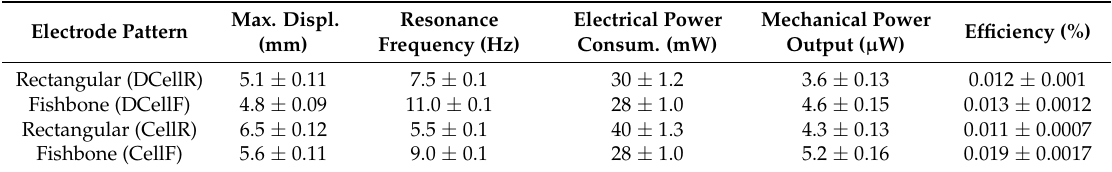
Table 4. Electrode pattern effect on the actuator performance of cellulose EAPap actuators at 5 V, 90% RH, 25 ◦ C